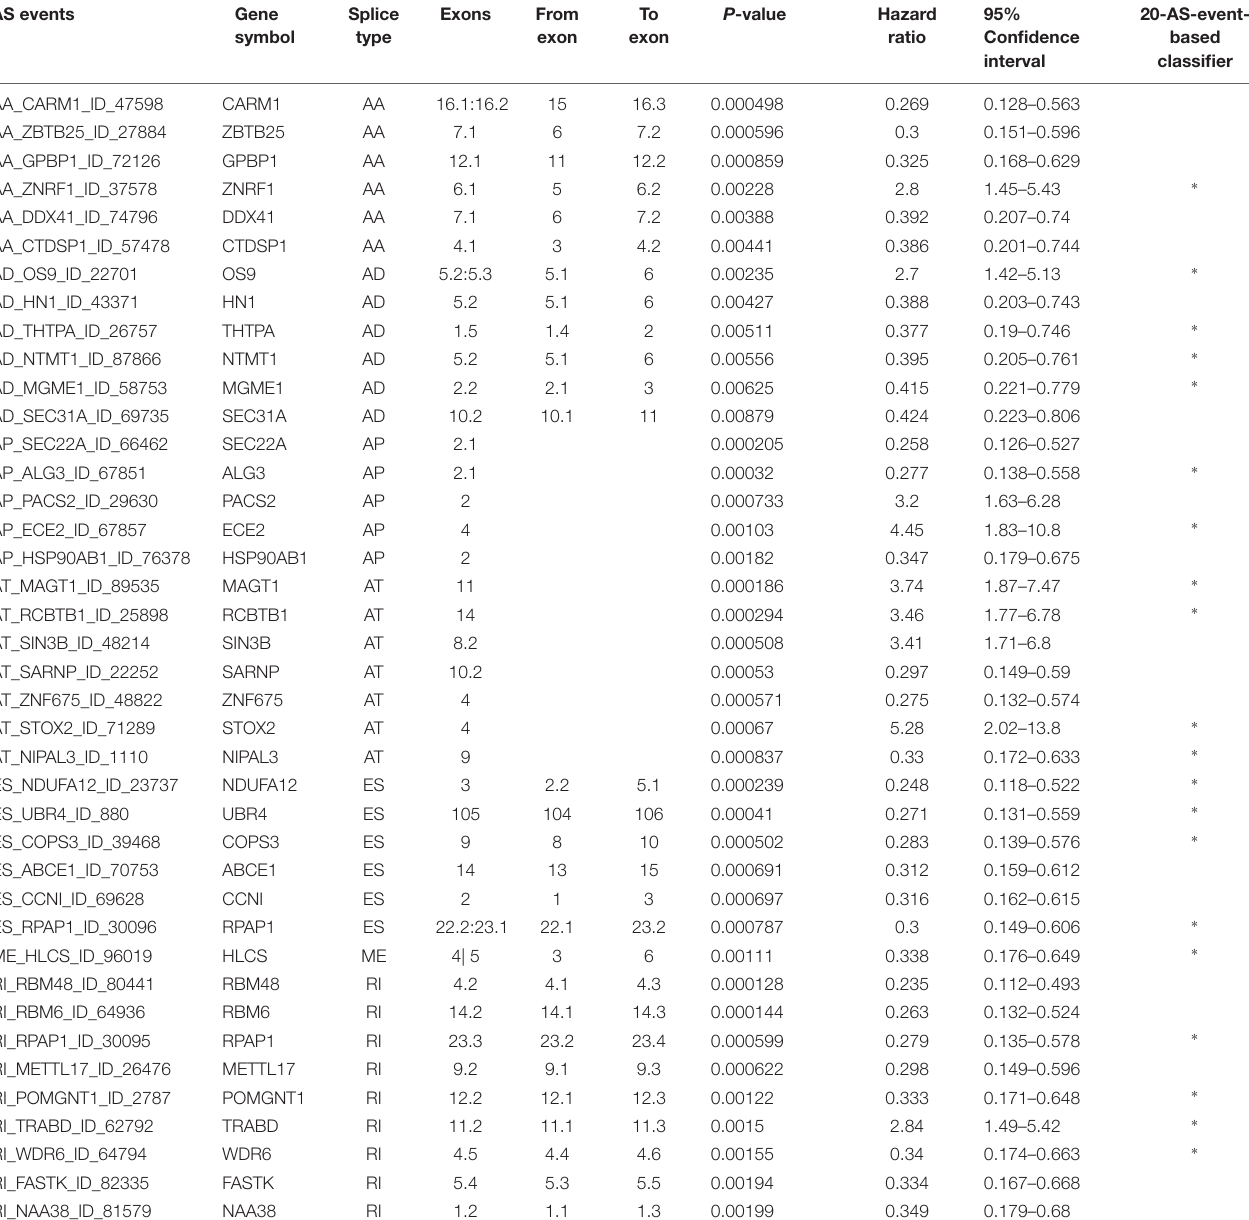
TABLE 1 | Detailed information of specific AS events involved in each AS signature and final prognostic